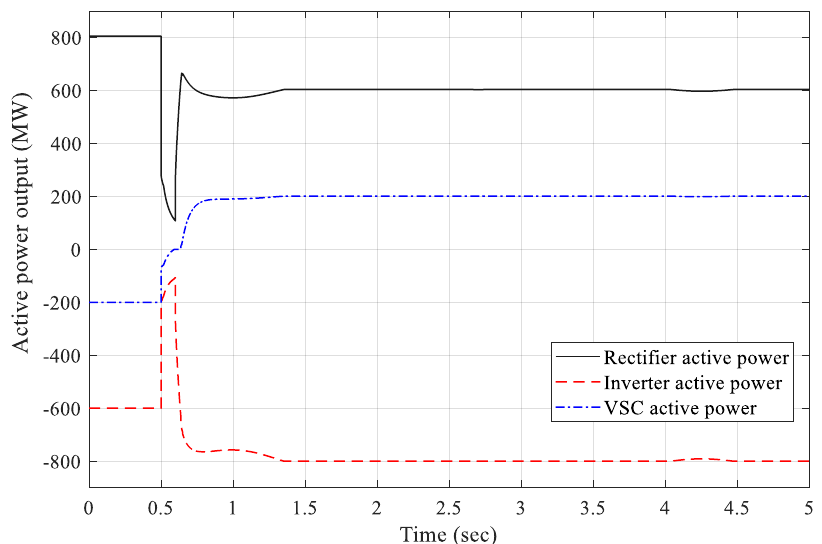
Figure 16. The active power output for each converter for the load side event with the operation strategy.